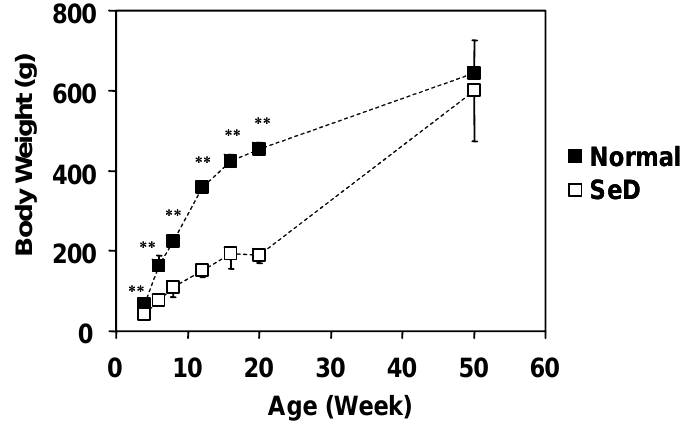
Figure 1. Dependence of body weight of normal and SeD rats on the age of the rats. The values are indicated as the mean ± SD. Significant difference between the normal and SeD groups are indicated by ** at p <